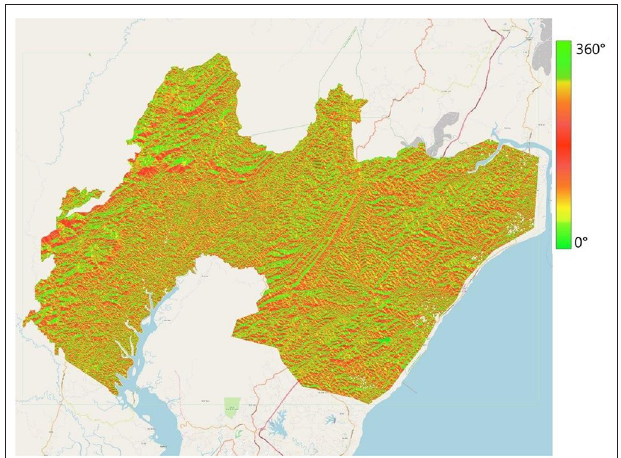
FIGURE 4 | Digital elevation model IKN area.